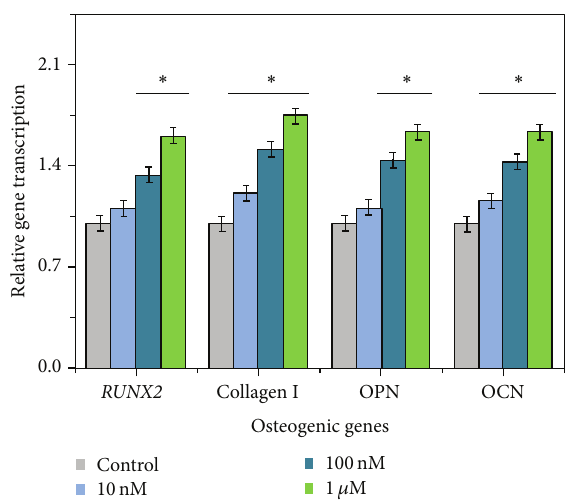
Figure 8: RT-PCR for the determination of osteoblastic marker expression was performed on day 14 after induction. Data were presented as the mean ± SD ( 𝑛 = 6 ). ∗ is compared with control group, 𝑃 < 0.05 . RUNX2 , collagen I, OPN, and OCN expression were significantly determined in the treatment groups and were positively correlated with the naringin concentration. Among them, 1 𝜇 M naringin showed the most positive